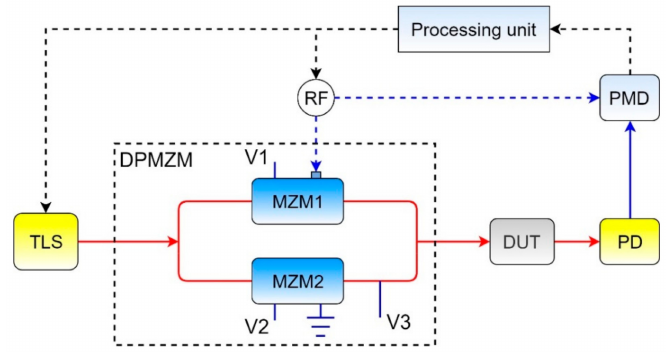
Figure 6. The schematic diagram of the OVA based on symmetric ODSB and DPMZM: TLS—tunable laser source; MZM—Mach–Zehnder modulator; DPMZM—dual-parallel MZM; RF—radiofrequency; DUT—device under test; PD—photodetector; PMD—phase-magnitude detector; red lines—optical signal; blue lines—electrical signal; dotted line—data path (adapted from